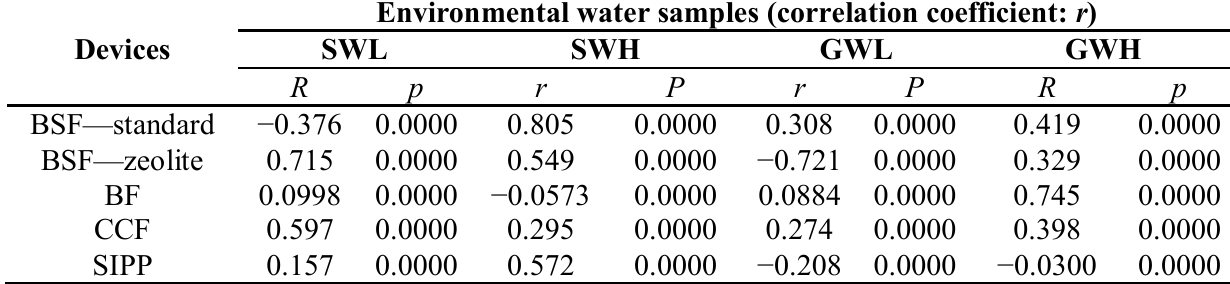
Table 4. Correlation between mean turbidity values of source water and mean flow rates of HWTS devices during filter